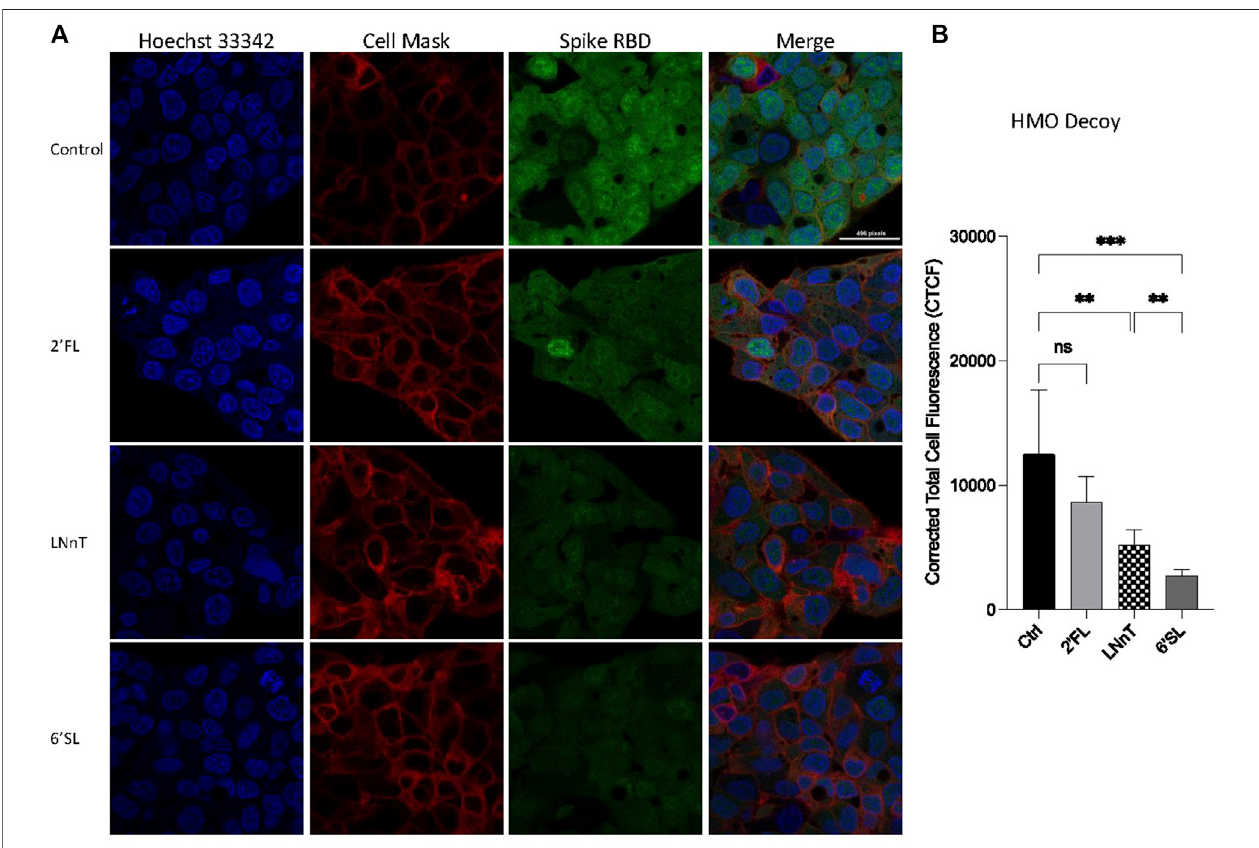
FIGURE 2| Inhibition of HMOs on the binding between HepG2 cells and Spike protein RBD. Fluorescent labelled proteins were preincubated with 1 mg per ml 2 ′ - FL, 6 ′ -SL, and LNnT, respectively. The preincubation was performed at room temperature for 30 min. (A) Immuno fl uorescence for S protein RBD binding. The columns (from left to right) show staining of nuclear acid (Hoechst 33342), plasma membrane (CellMask ™ Deep Red), S protein RBD, and merged image. Scale bar, 496 pixels. (B) Quanti fi cation of fl uorescent intensity of spike protein RBD binding. Fluorescence intensity was quanti fi ed for selected cell area. Quanti fi cation was performed with software ImageJ. Asterisks indicate the statistical signi fi cance between groups compared (** p < 0.01%; *** p < 0.001%; ns p < 0.05).